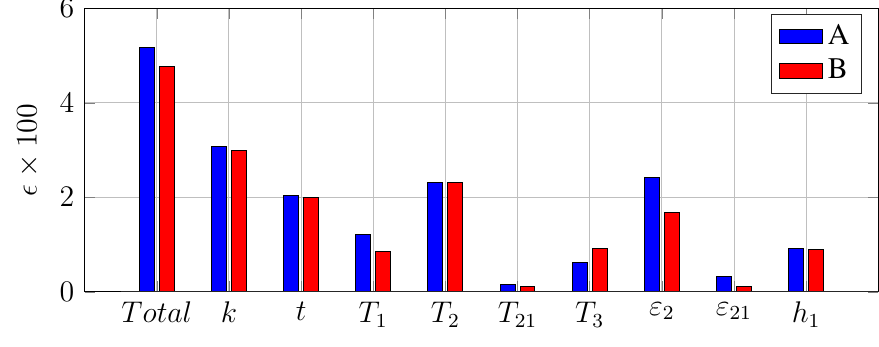
Figure 10. Individual uncertainty contribution at point A and